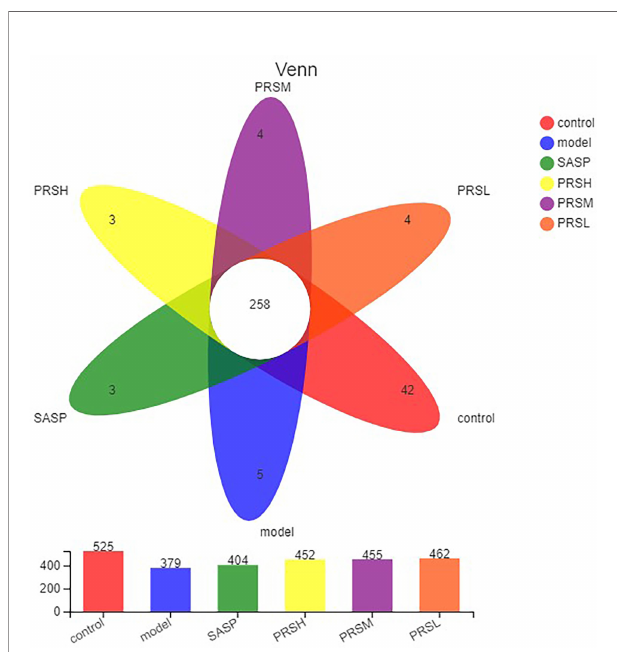
FIGURE 7 | OTU analysis of intestinal microbes in UC rats.